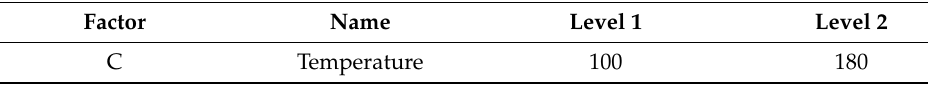
Table 2. Numeric factor and its levels in combined design.